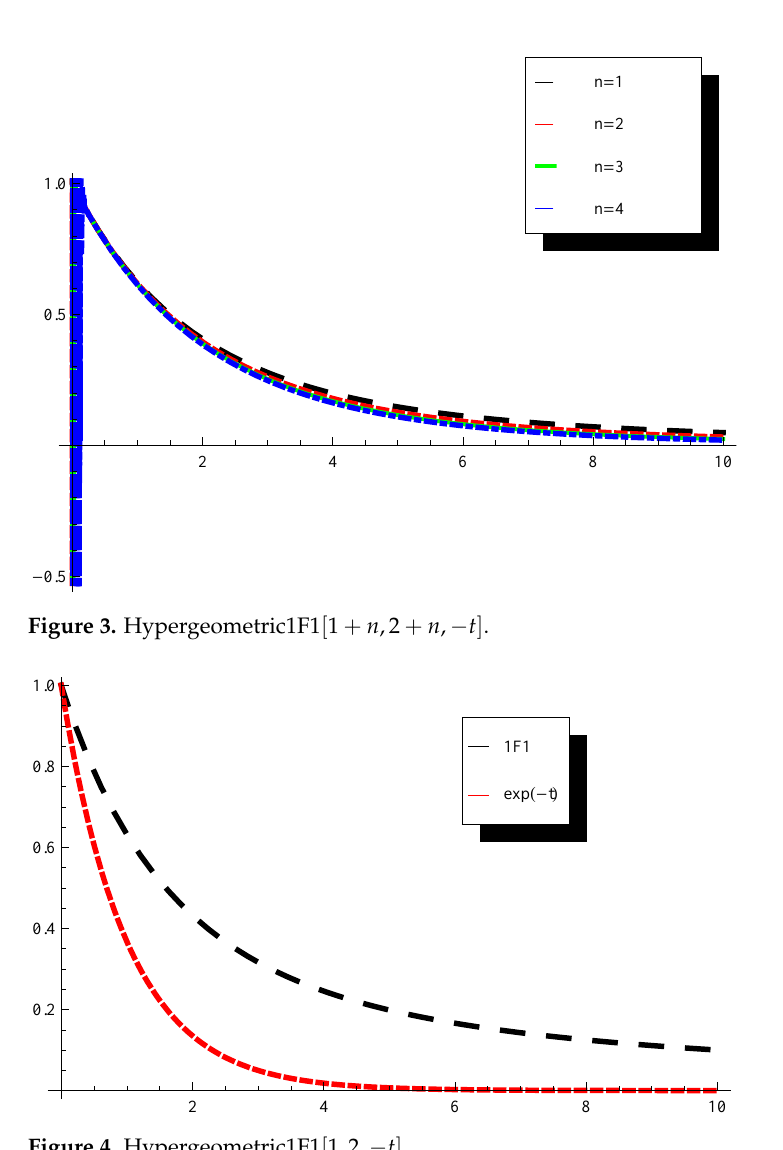
, is plotted in Figures 5–8. L